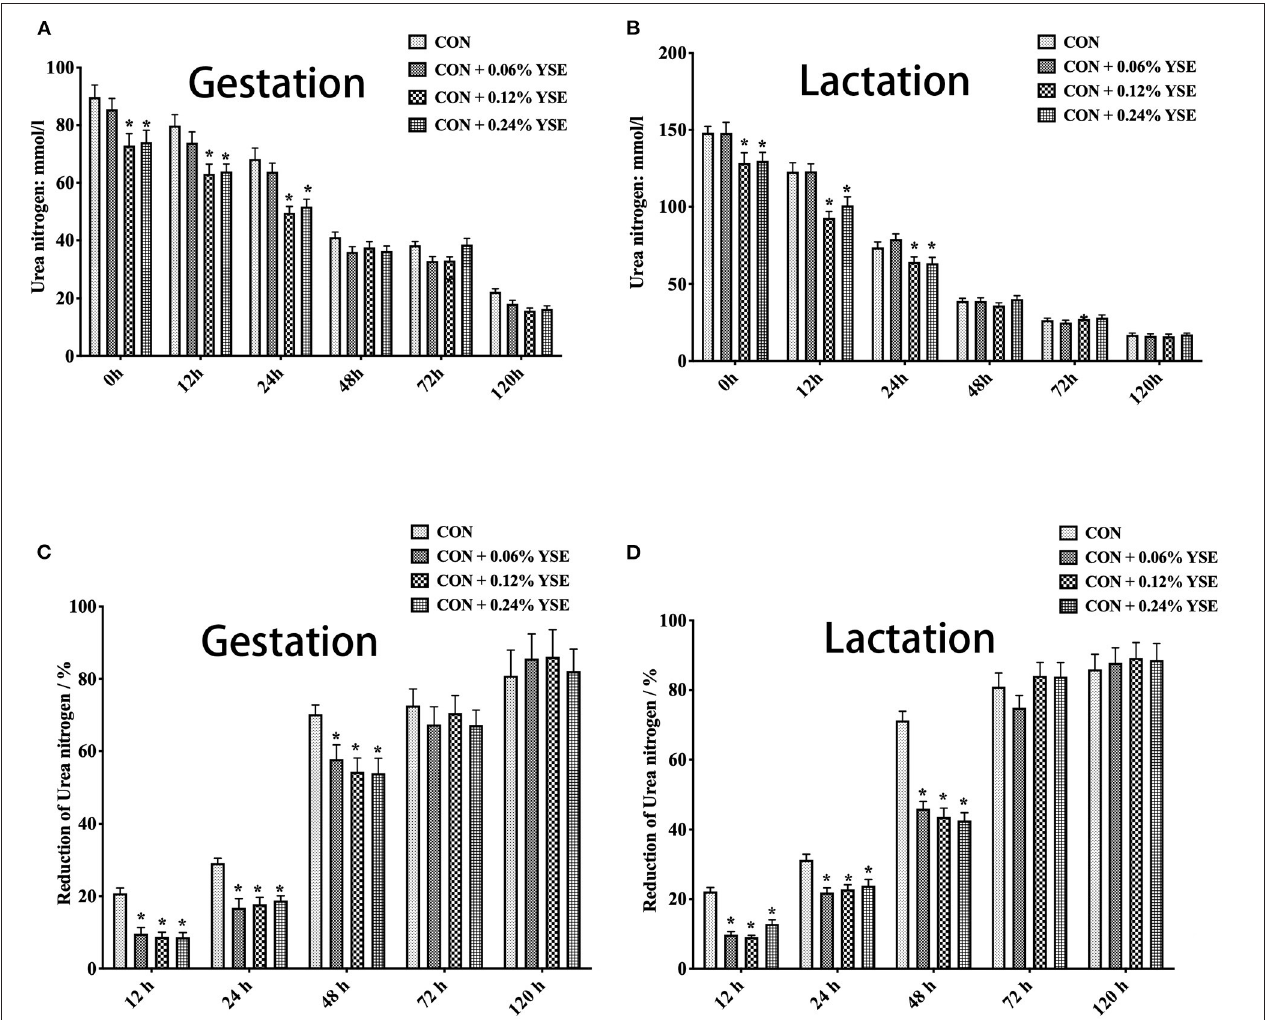
FIGURE 2 | The effect of dietary YSE supplementation on urea nitrogen content and loss of urea nitrogen in manure of gestating and lactating sows during storage. (A) The effect of dietary YSE supplementation on urea nitrogen content in manure of gestating sows during storage; (B) The effect of dietary YSE supplementation on urea nitrogen content in manure of lactating sows during storage; (C) The effect of dietary YSE supplementation on loss of urea nitrogen in manure of gestating sows during storage; (D) The effect of dietary YSE supplementation on loss of urea nitrogen in manure of lactating sows during storage. * means significant